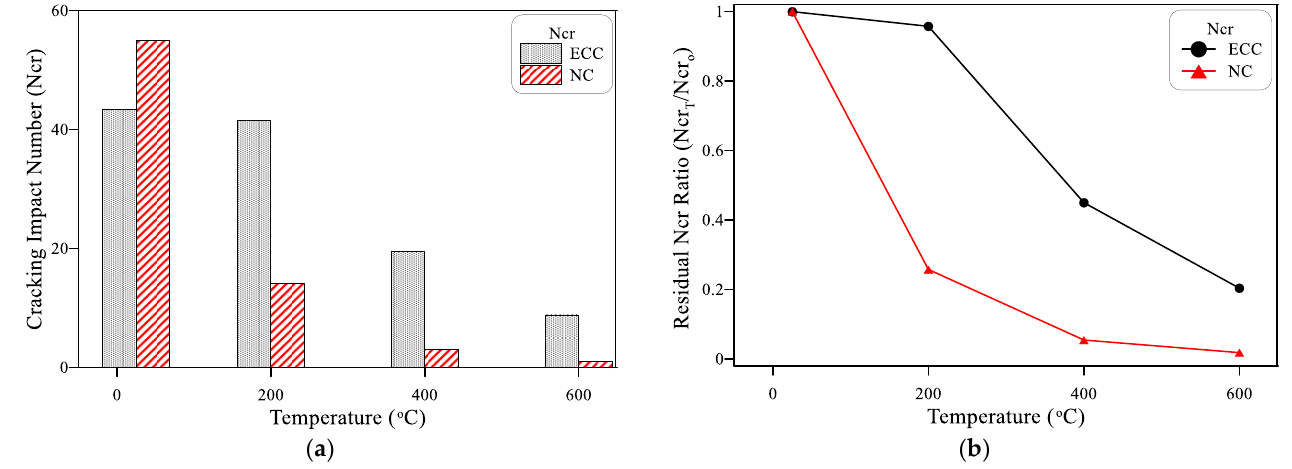
Figure 9. Residual cracking impact numbers of ECC and NC at different temperatures; ( a ) cracking number; ( b ) residual ratio of cracking number.